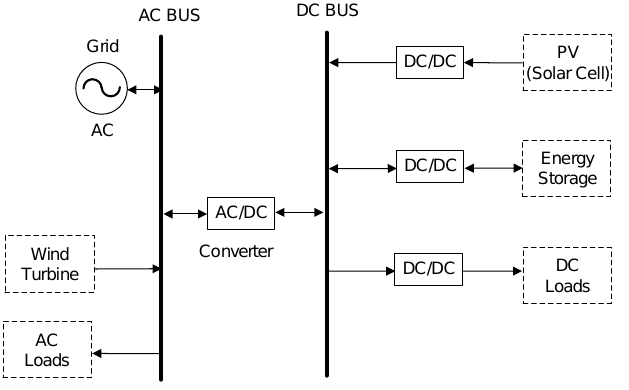
Figure 3. Typical configuration of a hybrid AC/DC microgrid.